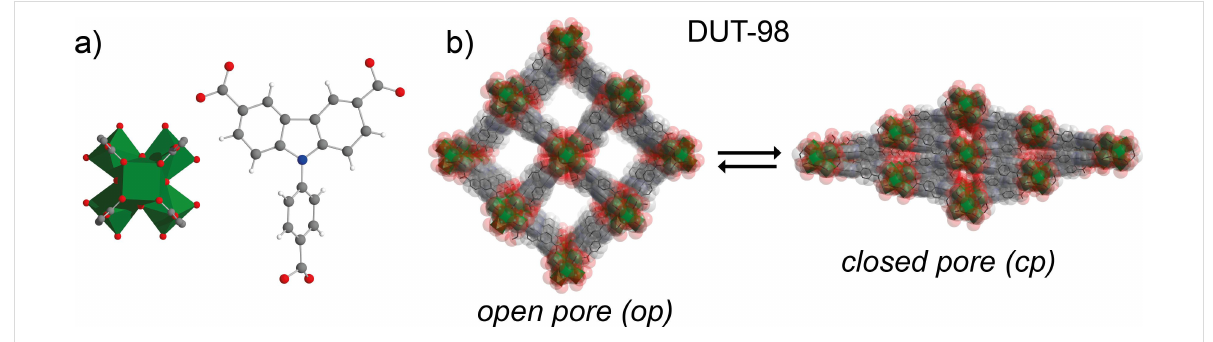
Figure 1: a) Zr-oxo cluster (green) and organic ligand CPCDC (9-(4-carboxyphenyl)-9 H -carbazole-3,6-dicarboxylate) applied in the construction of DUT-98; b) crystal structure transformation of DUT-98 open pore ( op ) to closed pore ( cp )